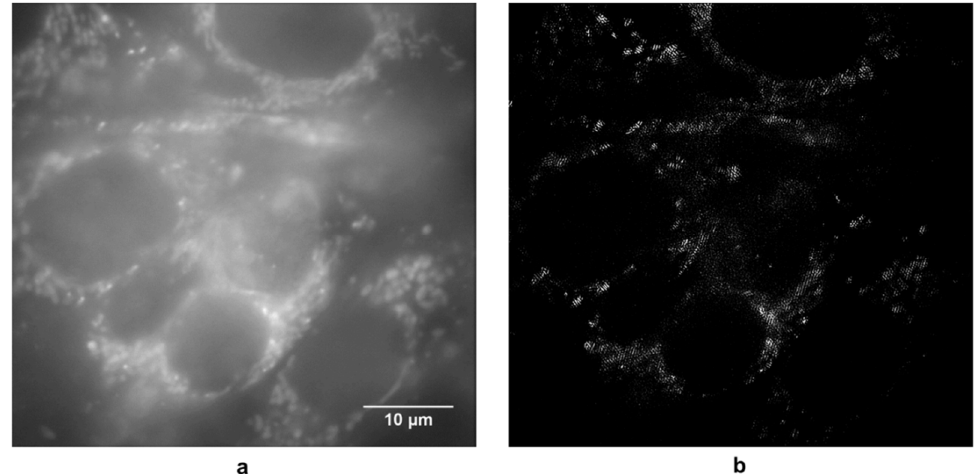
Figure 7. 3T3 fibroblasts from a multilayer incubated with the mitochondrial marker R123 (5 µM for 30 min); wide field image ( a ) and SIM image ( b ) in a sample depth Δz = 10 µm. Excitation wavelength: λ 0 = 488 nm; detection range: λ D ≥ 515 nm; Plan Neofluar 40×/1.30 oil immersion objective lens.